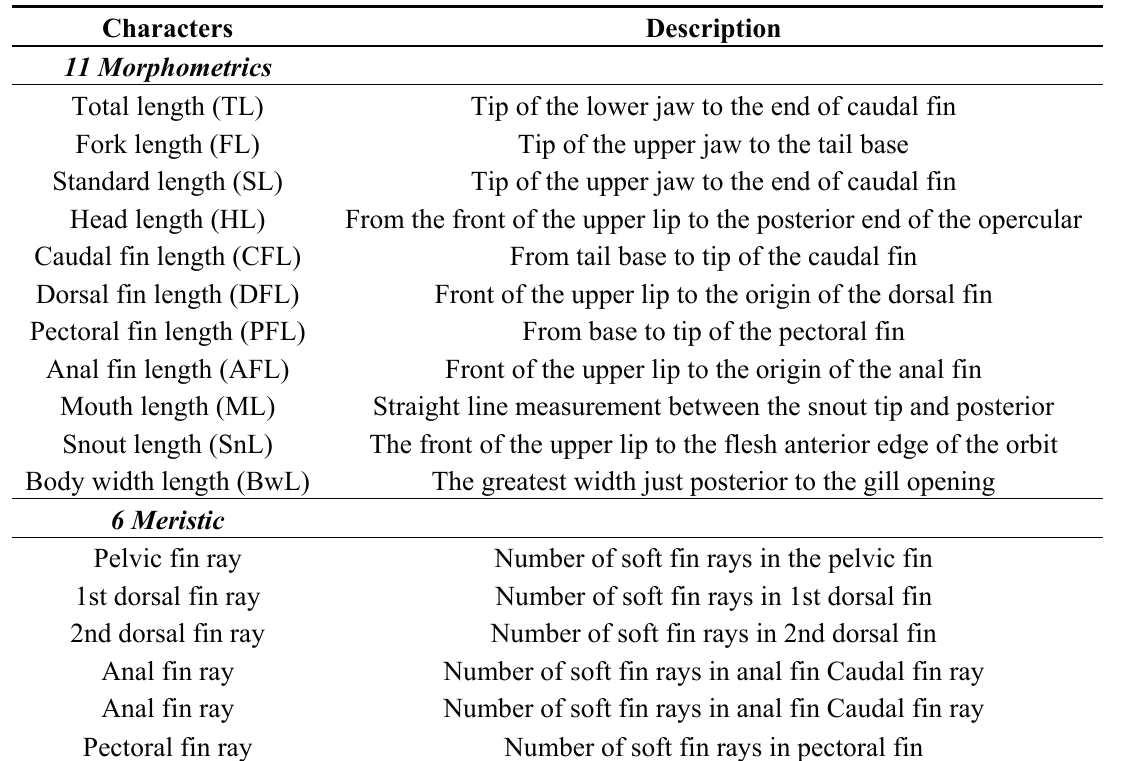
Figure 2. Morphology, morphometric and meristic characteristics ( A ) Epinephelus hexagonatus ; ( B ) Epinephelus fuscoguttatus ; ( C ) Bones of Epinephelus hexagonatus and ( D ) Bones of Epinephelus fuscoguttatus. Table 1. Definitions of morphometric measurements and meristic counts used in this